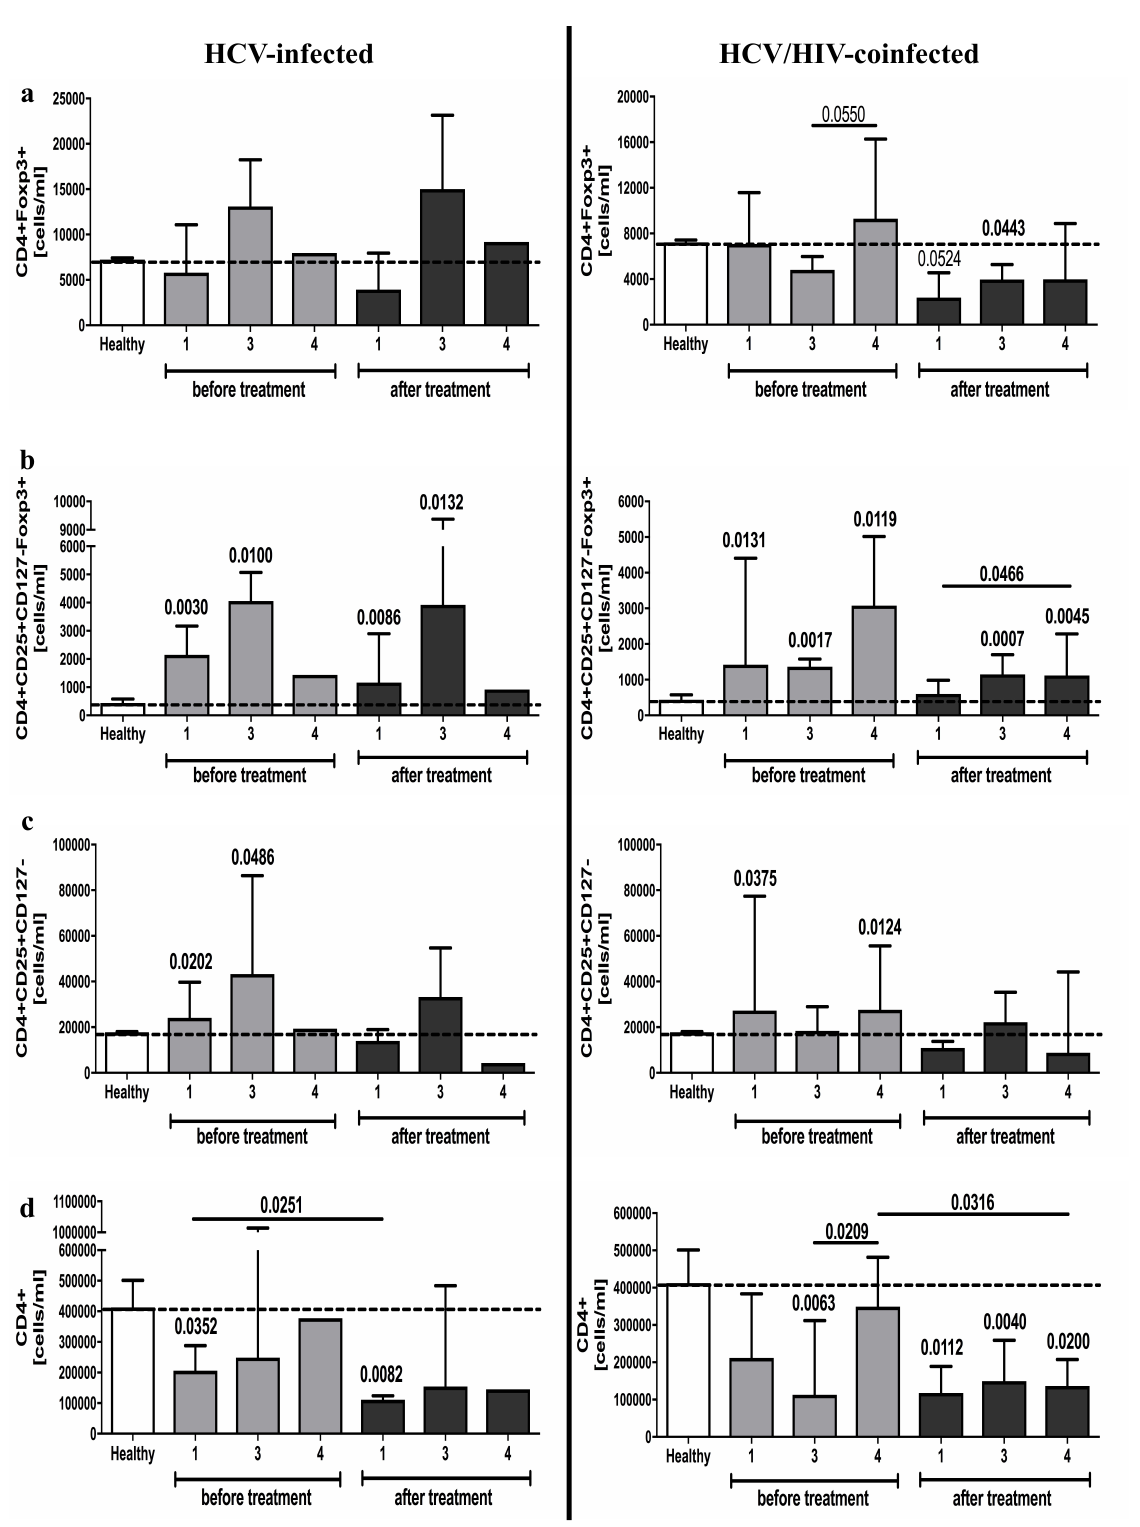
Figure 6. HCV virus genotype-related differences in regulatory T cells absolute numbers in response to anti-viral therapy in HCV-infected (left column) and HCV/HIV-coinfected patients (right column). Treg-related parameters in HCV or HCV/HIV-coinfected patients presented as absolute numbers: Foxp3 + ( a ), CD25 + CD127 − Foxp3 + ( b ), CD25 + CD127 − ( c ) CD4 + lymphocytes, and total CD4 + cells ( d ). Significant changes in relation to healthy controls indicated directly above specific group column; additional differences distinguished with lines connecting significantly different